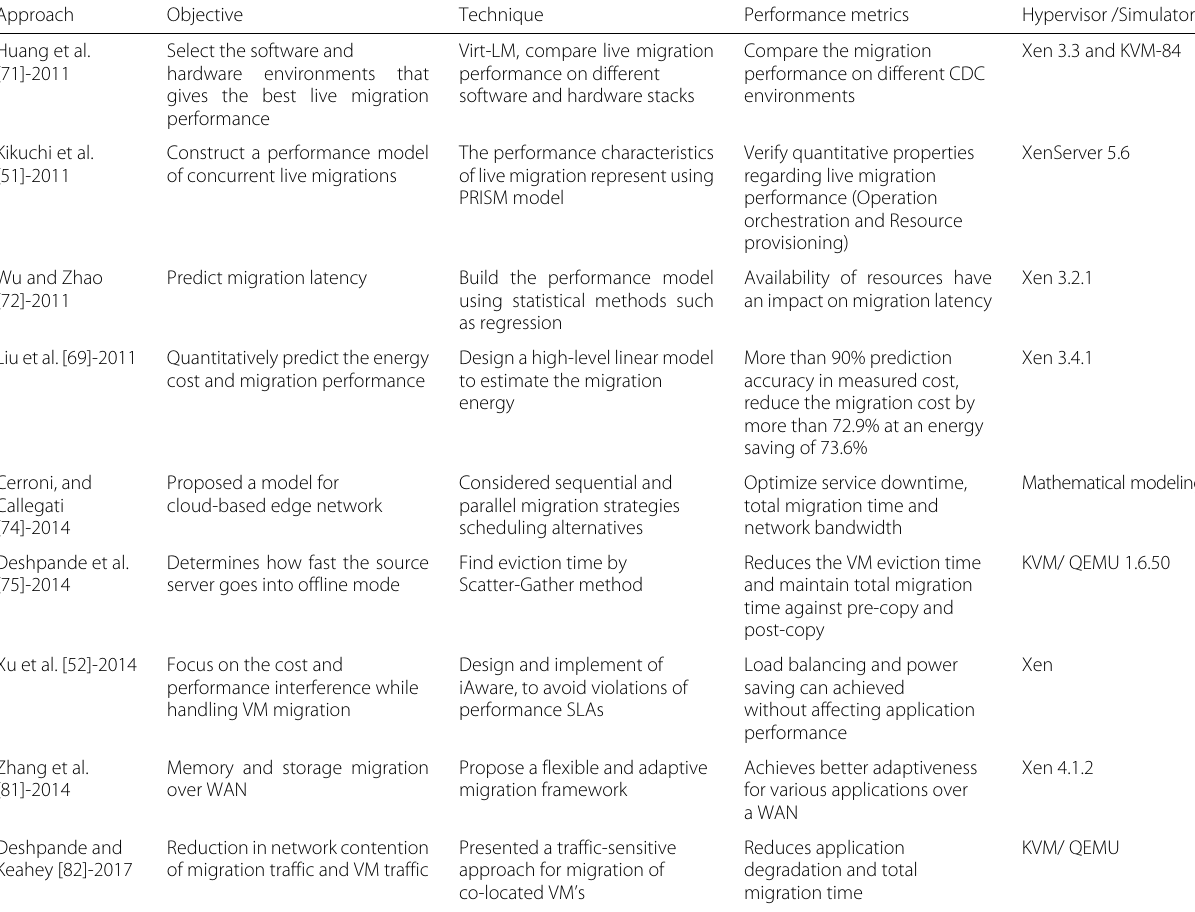
Table 3 Comparison of Live VM migration models Approach